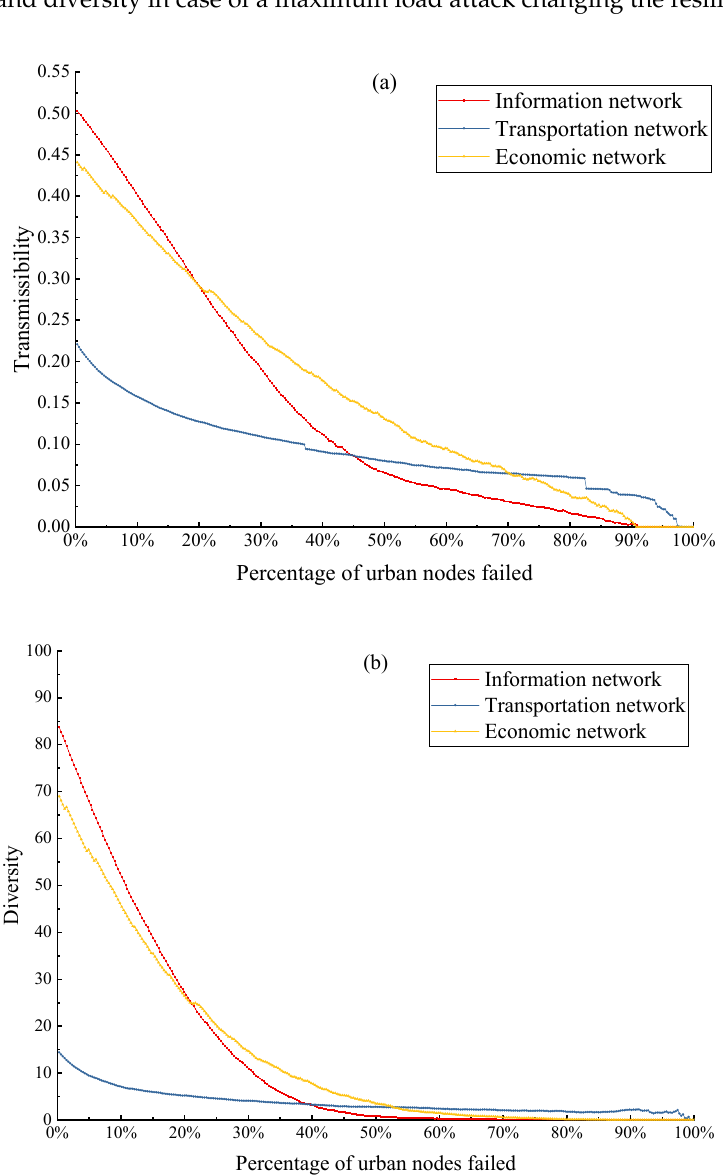
Figure 8. Changes of transmissibility ( a ) and diversity ( b ) in networks after maximum load attack.